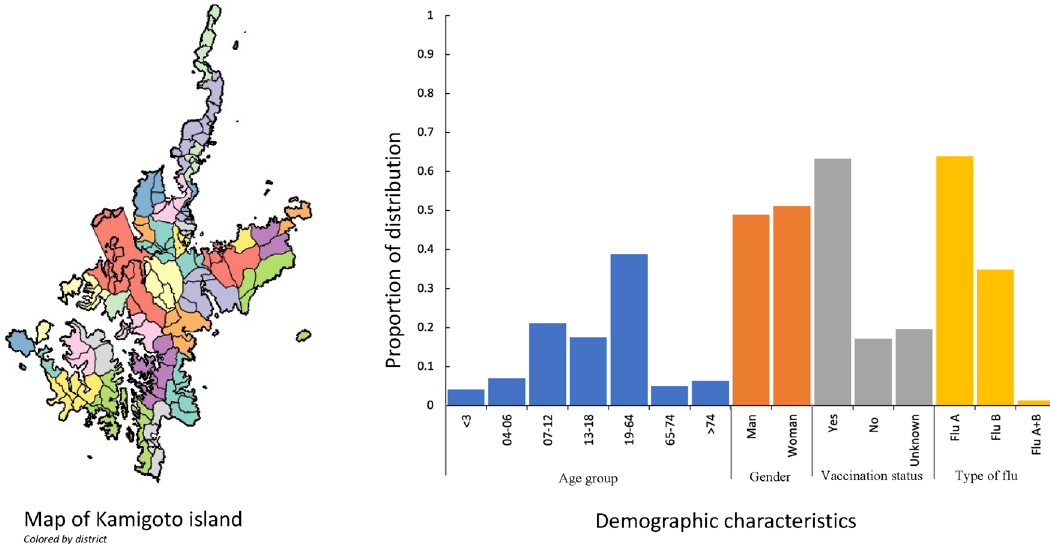
Figure 1. Map of Kamigoto island (each color represents a district), and demographic characteristics of the surveillance dataset of influenza, Kamigoto Island, Japan 2010/11–2017/18 influenza